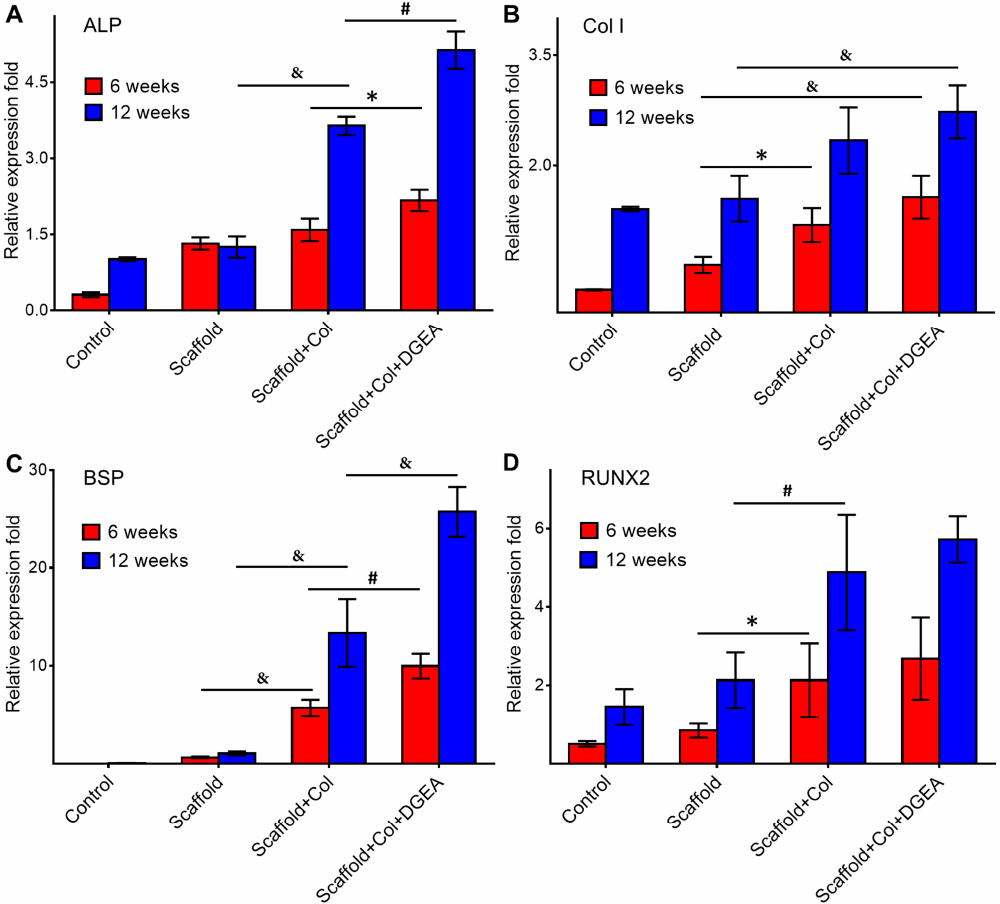
Figure 4. Expression of ( A ) ALP, ( B ) Col I, ( C ) BSP, and ( D ) RUNX2 mRNA in skull defect sites as detected by RT-PCR at 12 weeks post-implantation ( n = 5; * p < 0.05, # p < 0.01, & p <